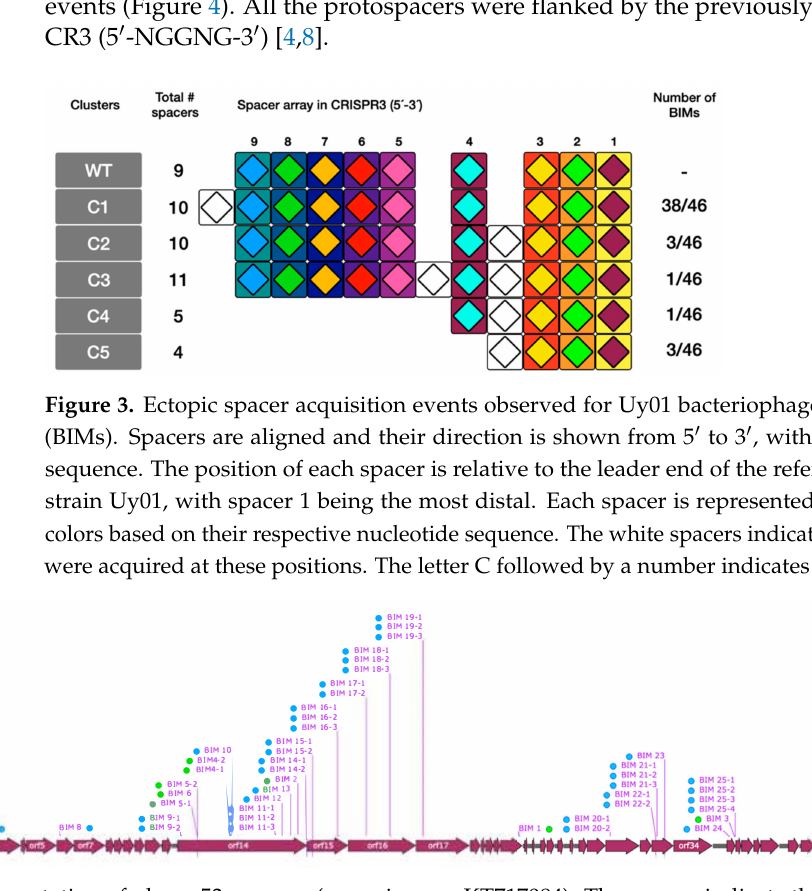
Figure 4. Graphic representation of phage 53 genome (accession no. KT717084). The arrows indicate the different open reading frames. The blue dots show the position of the protospacers acquired at the 5 (cid:48) end of the CR3 array by the BIMs obtained in this work. The green dots represent the position of protospacers acquired ectopically. The BIM number represents the different protospacers, and a hyphen followed by a number indicates that the protospacer was incorporated by more than one